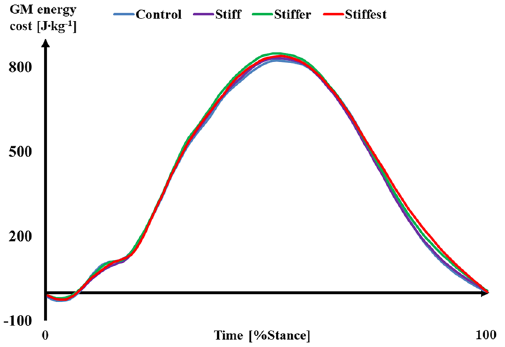
Figure 3. Average (n = 14) gastrocnemius medialis (GM) muscle energy cost over the stance phase of